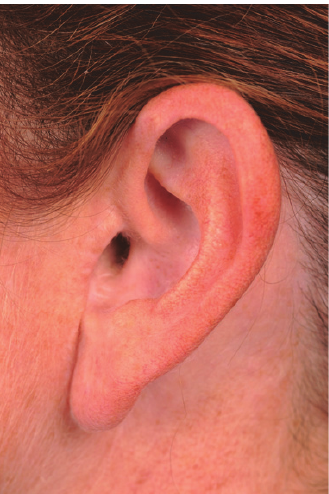
Figure 1: Preoperative photograph of a left tragus defect several years after excision for basal cell carcinoma.